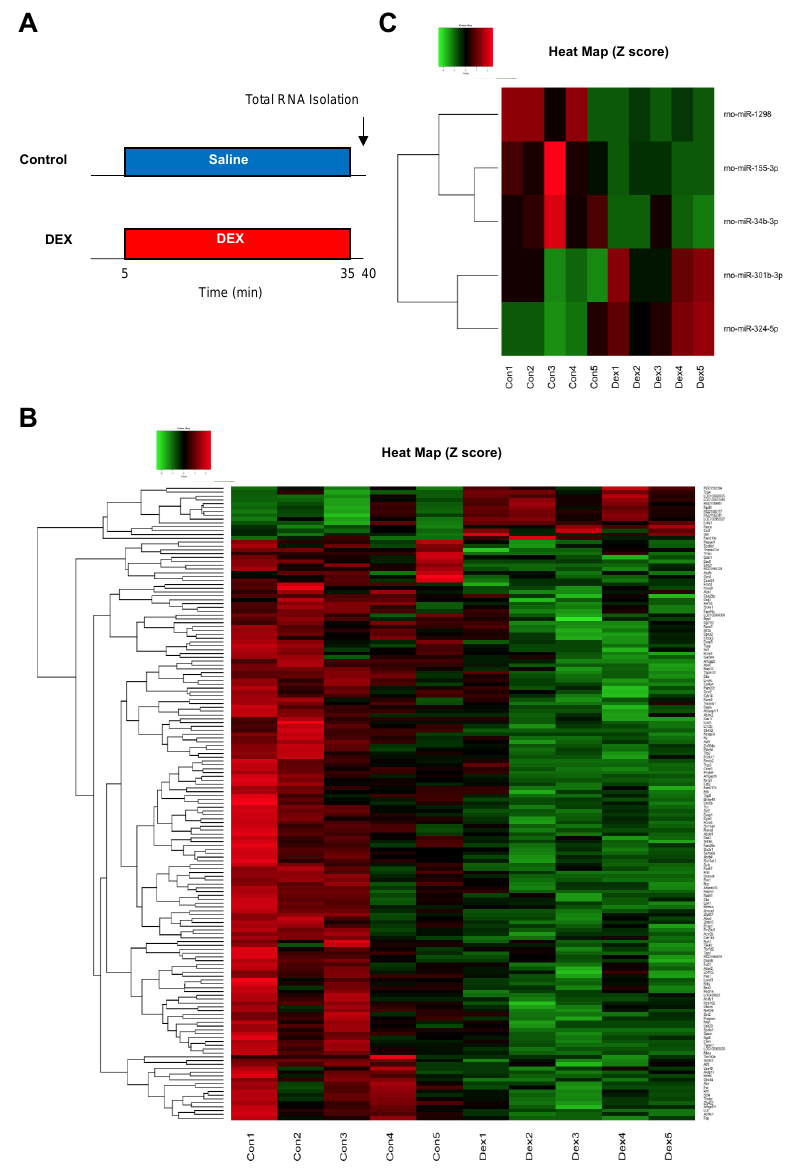
Figure 2. ( A ) Experimental protocol for analysis of differentially expressed mRNAs and miRNAs. ( B ) Heat map of differentially expressed mRNAs after administration of DEX. ( C ) Heat map of differentially expressed miRNAs after administration of DEX. The red and green colors represent >1.5-fold change (red: up-regulated genes, green: down-regulated genes). N = 5 in each group. DEX: dexmedetomidine.